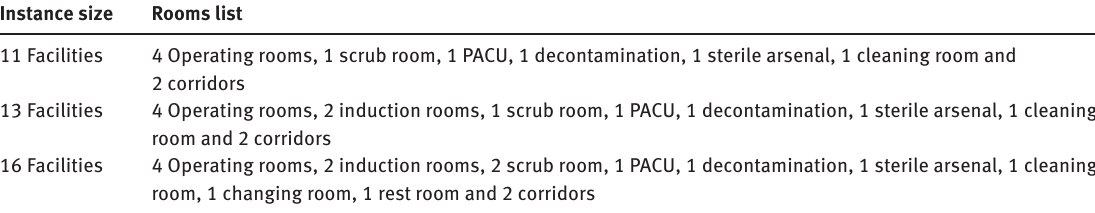
Table 2: Description of OT Instances According to OT Size.